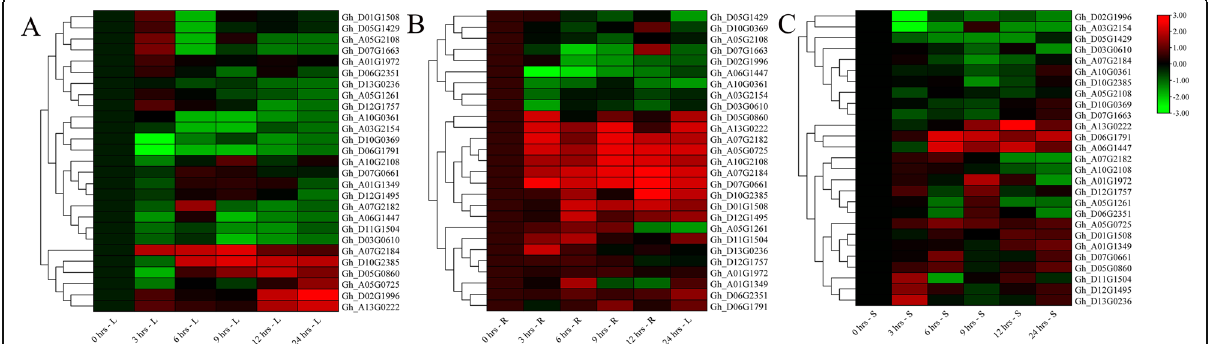
Fig. 9 Differential expression analysis of LHC gene family using RT-qPCR in G. hirsutum under drought stress. Red and green colors indicate high and low levels of expression, respectively. a Heat map showing gene expression in leaf tissue b Heat map showing gene expression in root tissue and c Heat map showing gene expression in stem